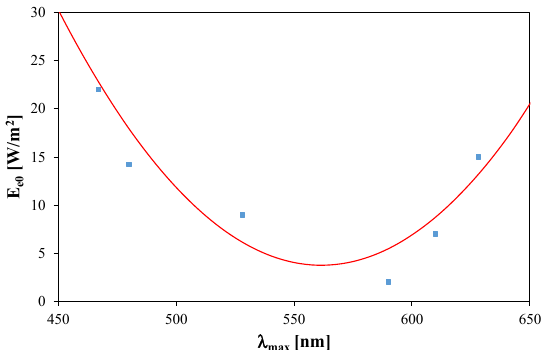
Figure 4. Computed and measured I–V characteristics of the tested power LEDs in lin-lin ( a ) and lin-log ( b ) scales.